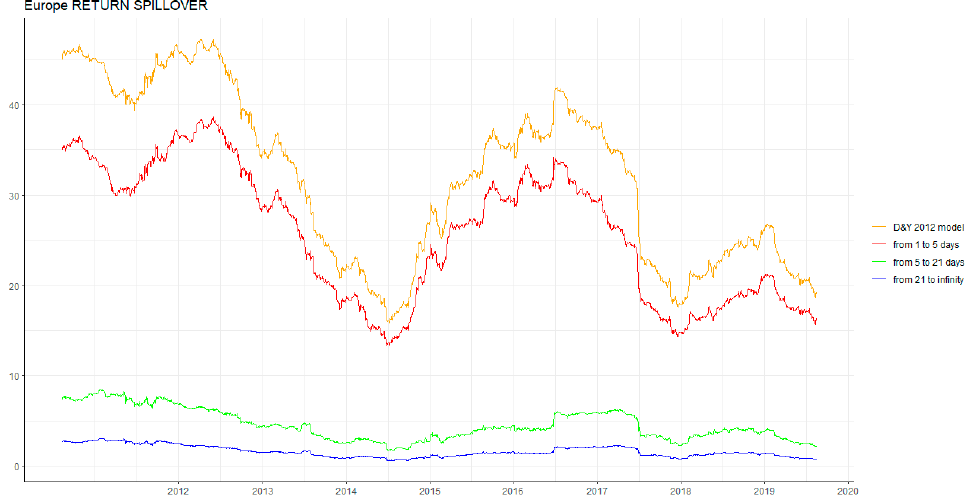
Figure A7. Total return spillover of DY12 and BK18 in Europe (Windows 250).